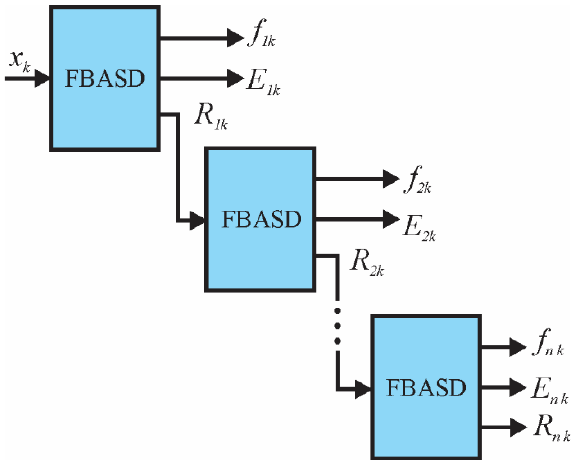
Figure 3. FBASD technique applied to extract N time-frequency components.